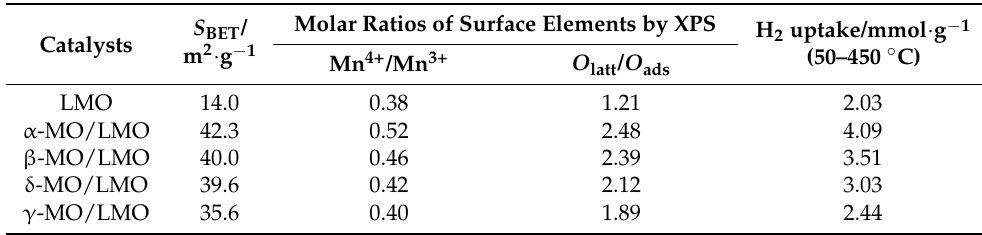
Table 2. Surface element compositions, surface area and reducibility of LMO, α -MO/LMO, β - MO/LMO, δ -MO/LMO and γ